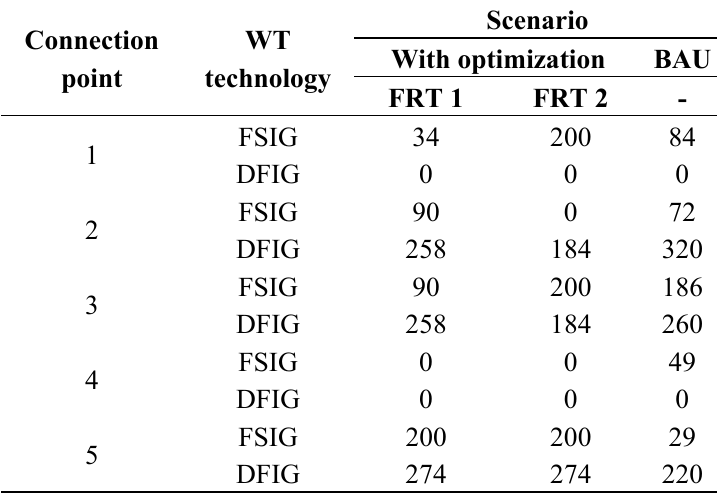
Table 4. WT distribution